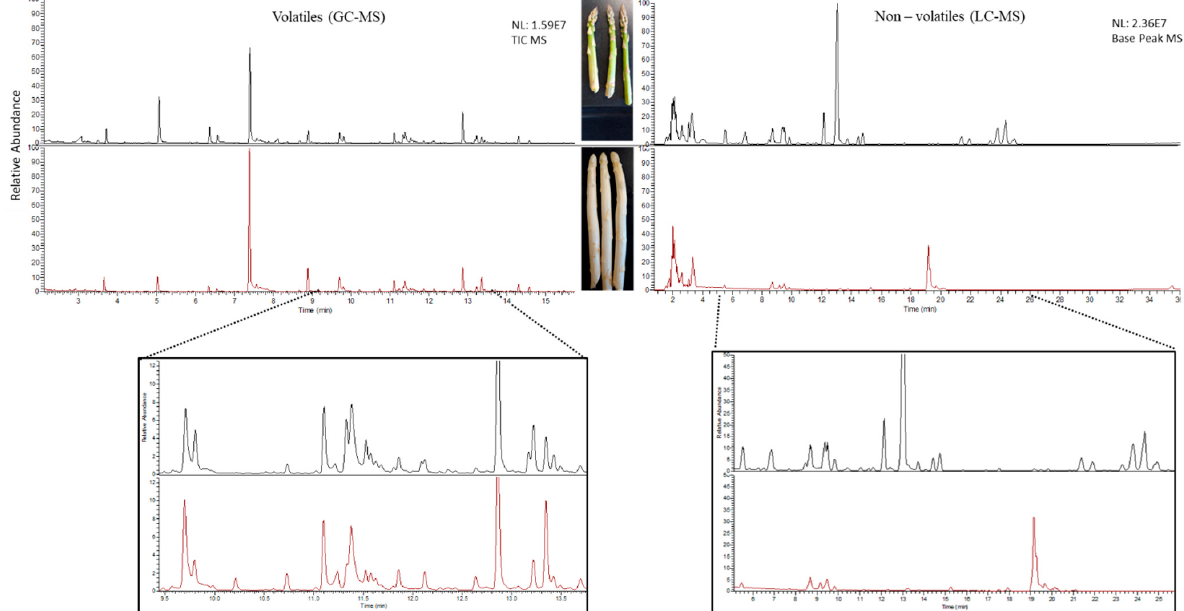
Figure 2. Raw chromatograms obtained from the GC-MS ( left ) and LC-MS ( right ) analysis of green ( upper ) and white ( lower ) asparagus spears.